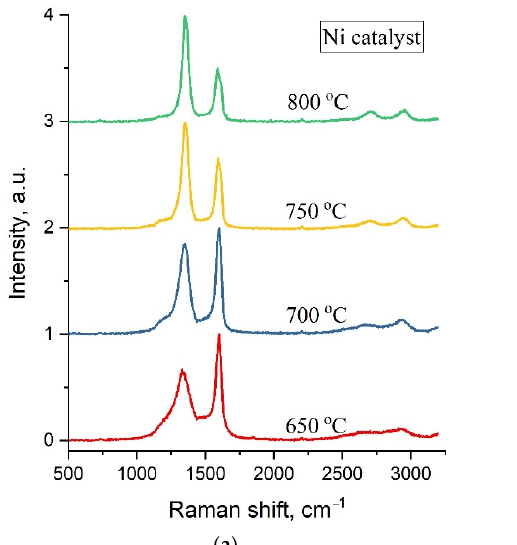
are shown in Figure 4.